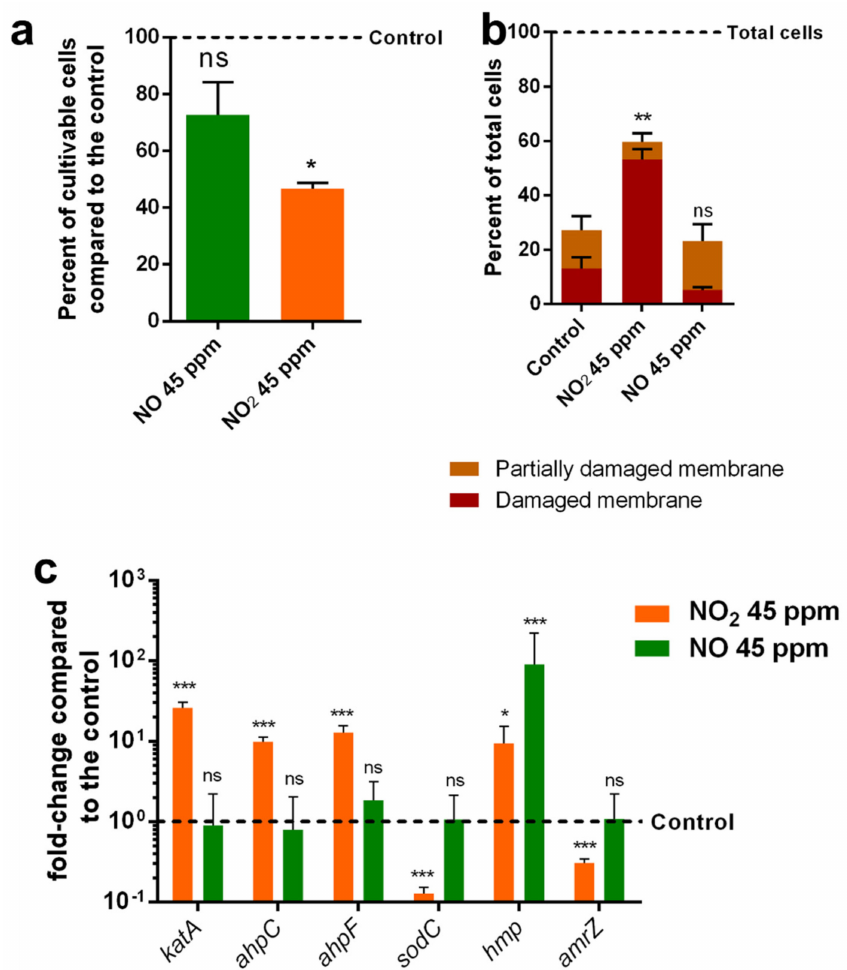
Figure 1. Physiological modifications of P. fluorescens MFAF76a after exposure to NO 2 or NO. ( a ) Cultivability of bacteria after exposure to NO 2 (in orange) or NO (in green) compared to cells exposed to synthetic air. ( b ) Membrane integrity assessed by live-dead flow cytometry assays using Live/Dead BacLight kit (L-7012, ThermoFisher) according to the manufacturer’s recommendations. ( c ) Expression of genes encoding proteins involved in RNS and ROS detoxification. Graphs represent means ± SEM. ns = p > 0.05; * = p < 0.05; ** = p < 0.01; *** = p < 0.001, N ≥